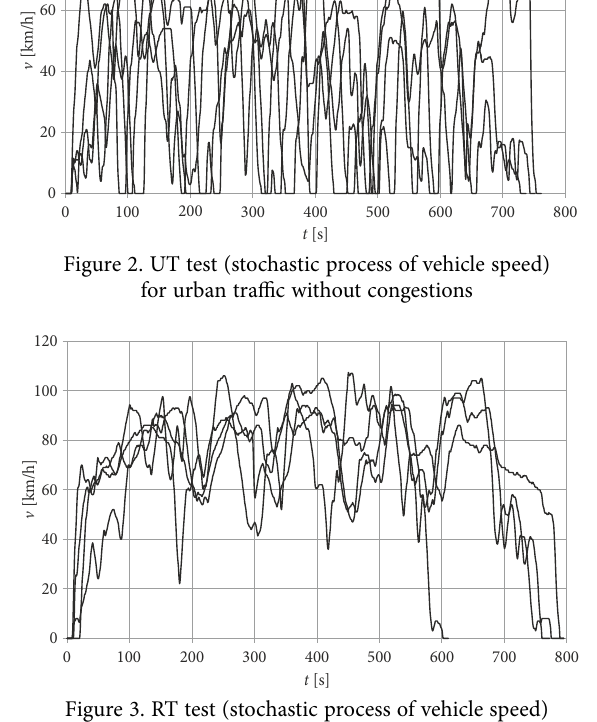
Figure 3. RT test (stochastic process of vehicle speed) for extra-urban (rural) traffic